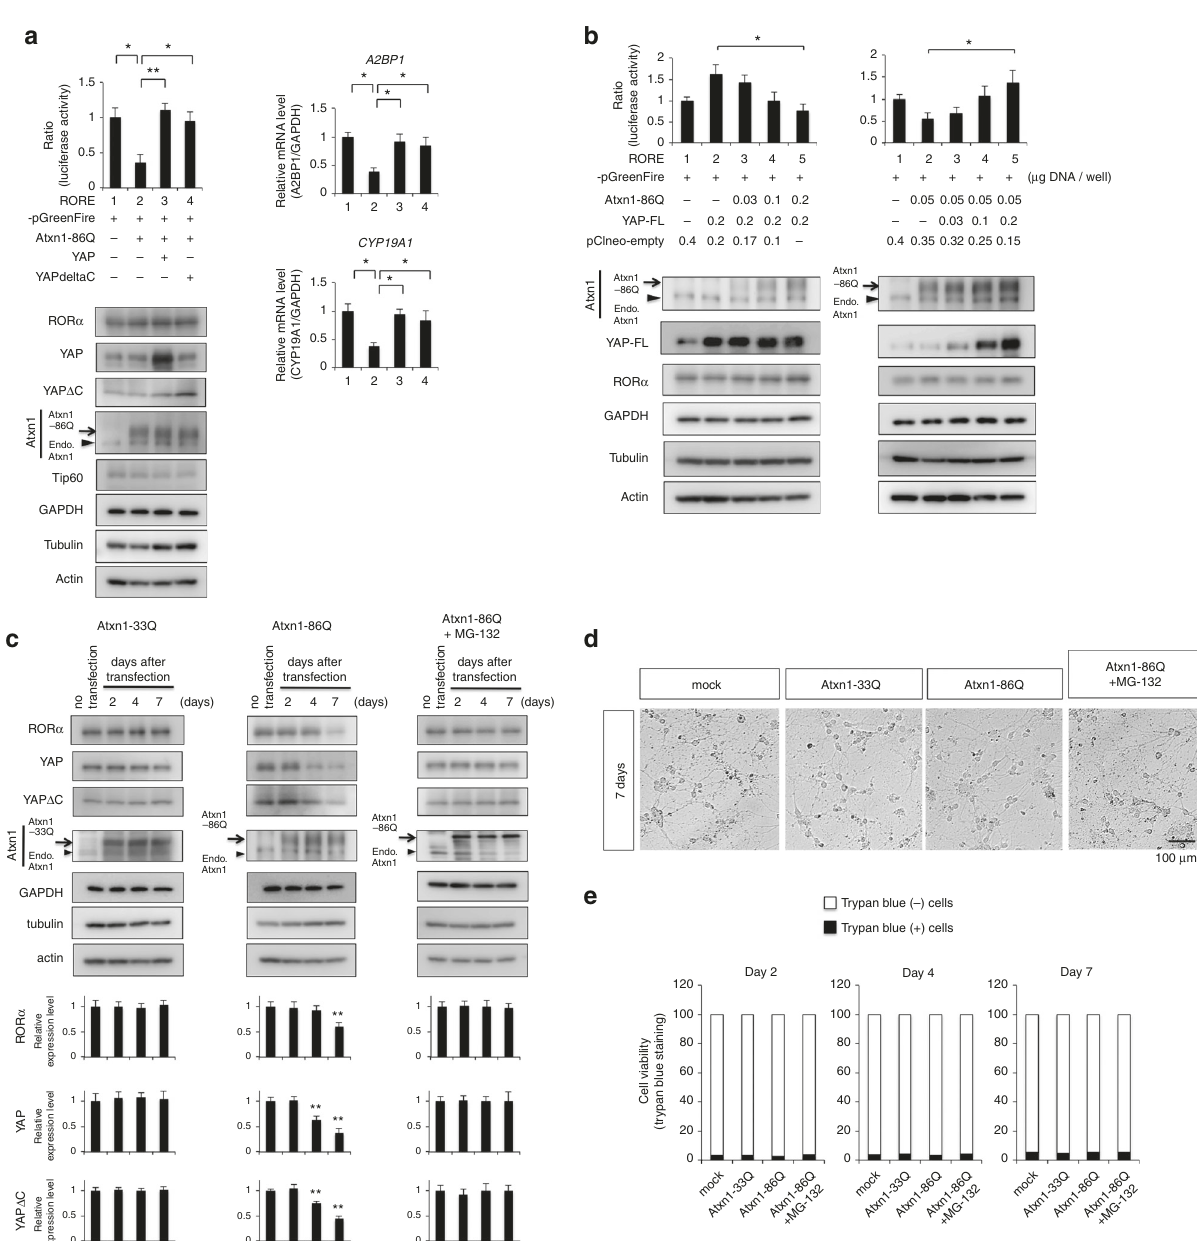
Fig. 7 YAP/YAPdeltaC restores ROR α target gene expression in vitro. a In primary cerebellar neurons, luciferase assays were performed 2 days after transfection of reporter and effector plasmids (left upper graph). Expression levels of ROR α , Atxn1-86Q, YAP, YAPdeltaC, Tip60, GAPDH, α -tubulin, and β - actin at the time of the luciferase assay are shown in the lower panels. Atxn1-86Q suppressed ROR α -mediated transcription immediately without decreasing the level of ROR α or YAP. Transcriptional suppression was rescued by co-expression of YAP or YAPdeltaC (right graphs). Double asterisks indicate statistical signi fi cance ( p < 0.01, N = 7) in one-way ANOVA with post-hoc Tukey ’ s HSD test. b Dose-dependent inhibitory effect of Atxn1-86Q (left panels) and dose-dependent rescue effect of YAP2 (right panels) on ROR α -mediated transcription. Double asterisks indicate statistical signi fi cance ( p < 0.01, N = 5) in one-way ANOVA with post hoc Tukey ’ s HSD test. Lower panels show the amounts of related proteins 2 days after transfection, as determined by western blot. c Protein levels of YAP, YAPdeltaC, Atxn1, GAPDH, α -tubulin, and β -actin were sequentially monitored until 7 days after transfection of Atxn1-33Q (left panels) or Atxn1-86Q (middle panels) to mouse primary neuron. YAP/YAPdeltaC were decreased from day 4, while ROR α was decreased at day 7. The ROR α level was not changed at 2 days, when ROR α -mediated transcription was suppressed in luciferase assay. MG-132 treatment (0.3 μ M, right panels) increased the level of YAP/YAPdeltaC and ROR α decreased by Atxn1-86Q. Quantitative analyses are shown in the lower graphs. Double asterisks indicate statistical signi fi cance ( p < 0.01, N = 5) in Dunnett ’ s test. d Cell death was not markedly increased at day 7 after transfection of Atxn1-86Q. e Cell viability was examined at days 2, 4, and 7 after transfection by trypan blue dye exclusion test among non-transfected, Atxn1-33Q-transfected, Atxn1-86Q-transfected, and Atxn1-transfected + MG-132 primary cerebellar neurons. Black area represents mean value of % dye-positive neurons ( N =